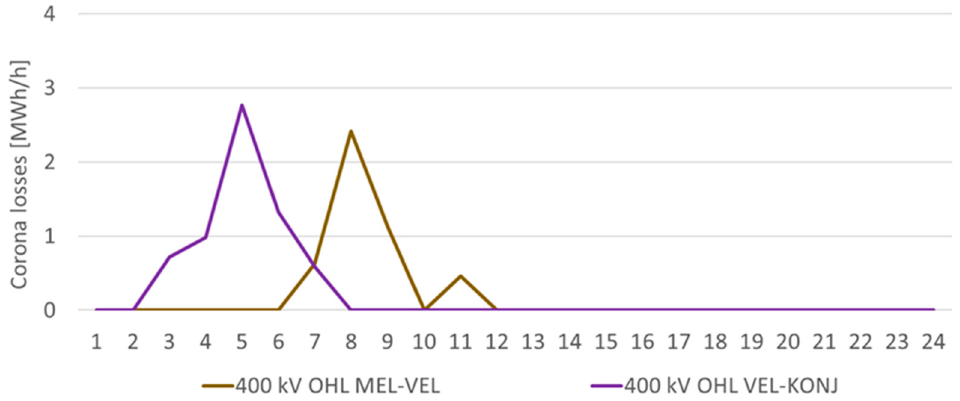
Figure 7. Estimated values of corona losses for 400 kV lines and correlations with the differential current angle during a